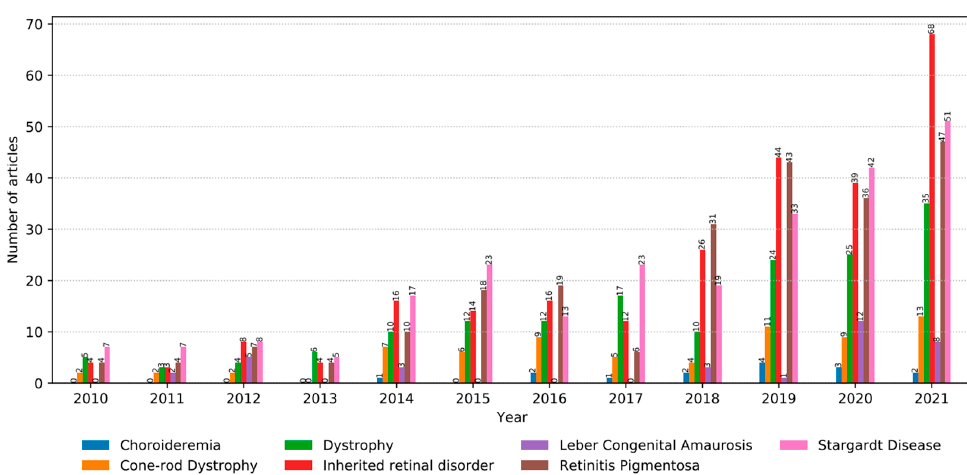
Figure 2. Keywords occurrence map.